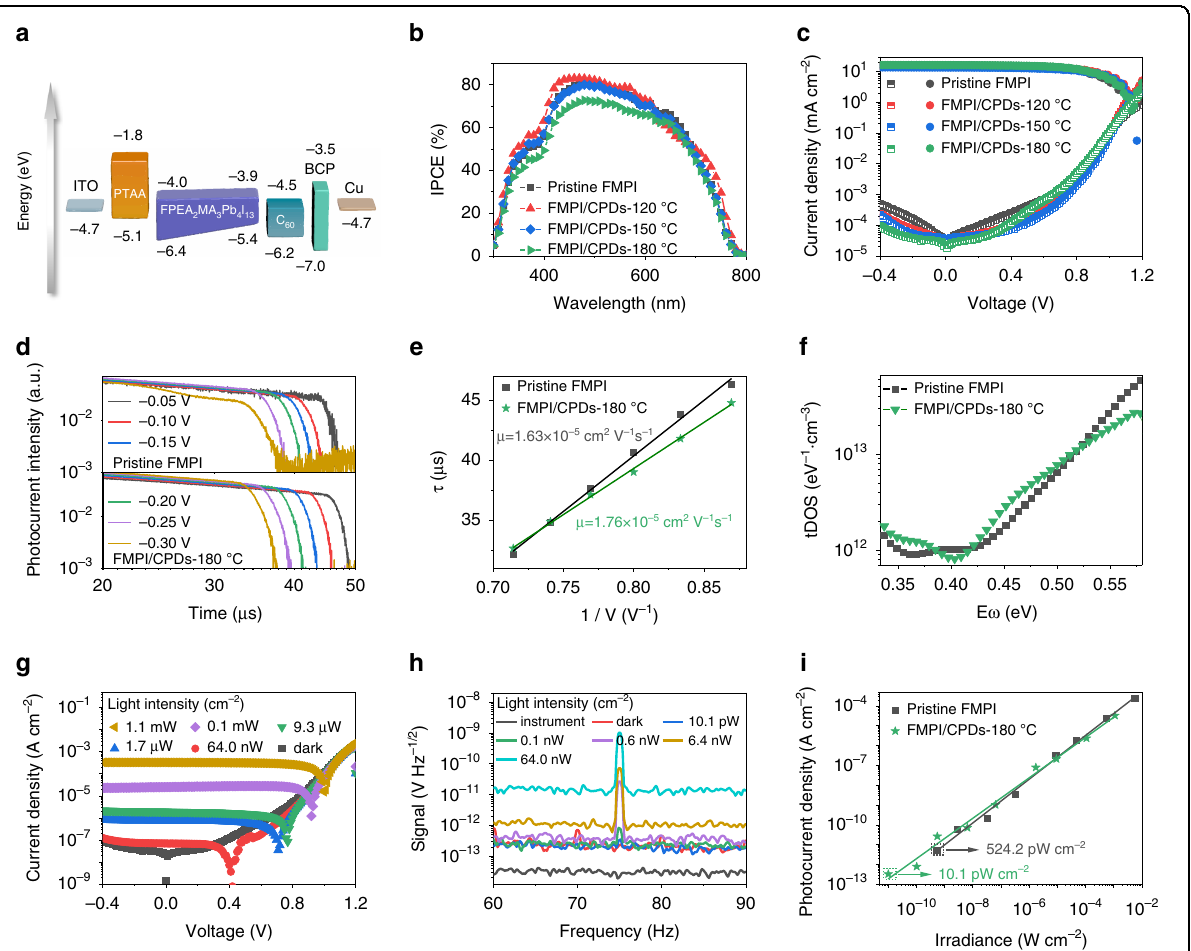
Fig. 4 Performance and characteristics of FMPI/CPDs photodetectors. a Band structure of the pristine FMPI photodetector device. b IPCE response and ( c ) I – V curves of pristine FMPI and FMPI/CPDs photodetectors. d ToF transients and ( e ) the calculated mobility results of pristine FMPI and FMPI/CPDs-180 °C devices. f The trap density of state for pristine FMPI and FMPI/CPDs-180 °C photodetectors. The light-dependent response of FMPI/CPDs-180 °C photodetectors ( g ) and ( h ) NEP measurements. i The LDR results of pristine FMPI and FMPI/CPDs-180 °C